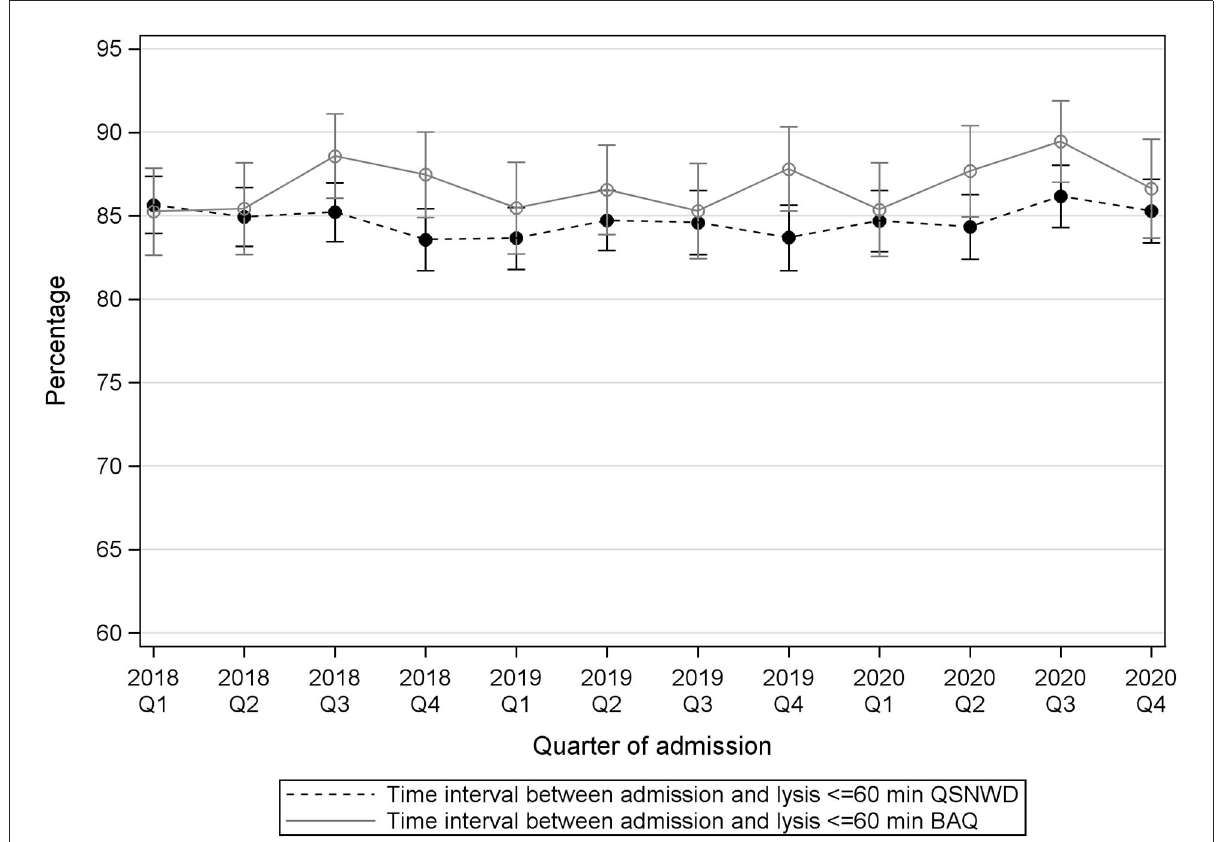
FIGURE6 Time interval between admission and thrombolysis ≤ 60min (in the same house) in patients with cerebral infarction, intravenous thrombolysis, a time interval event to admission of ≤ 4h (including in-house stroke), a NIHSS 4–25 and 18–80 years old from the registries QSNWD (dashed line) and BAQ (solid line) in 2018-2020 by quarter of